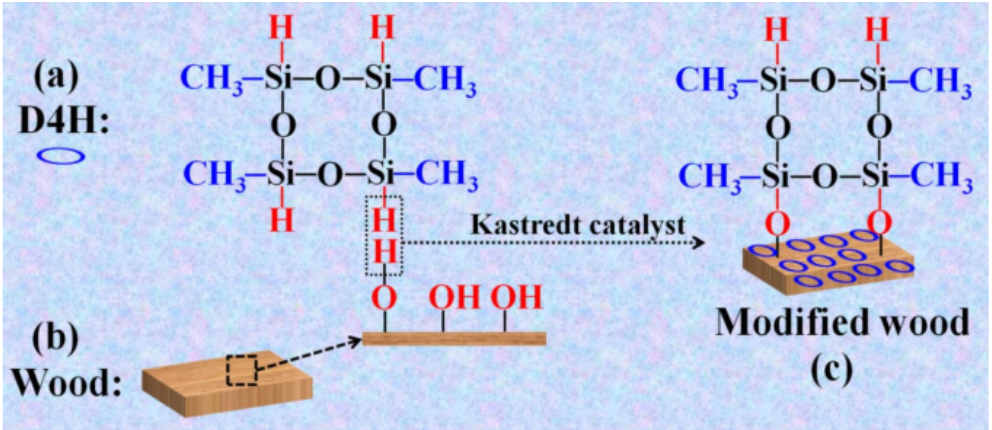
Figure 7. Schematic representation of the process for obtaining the D4H modified wood [84].